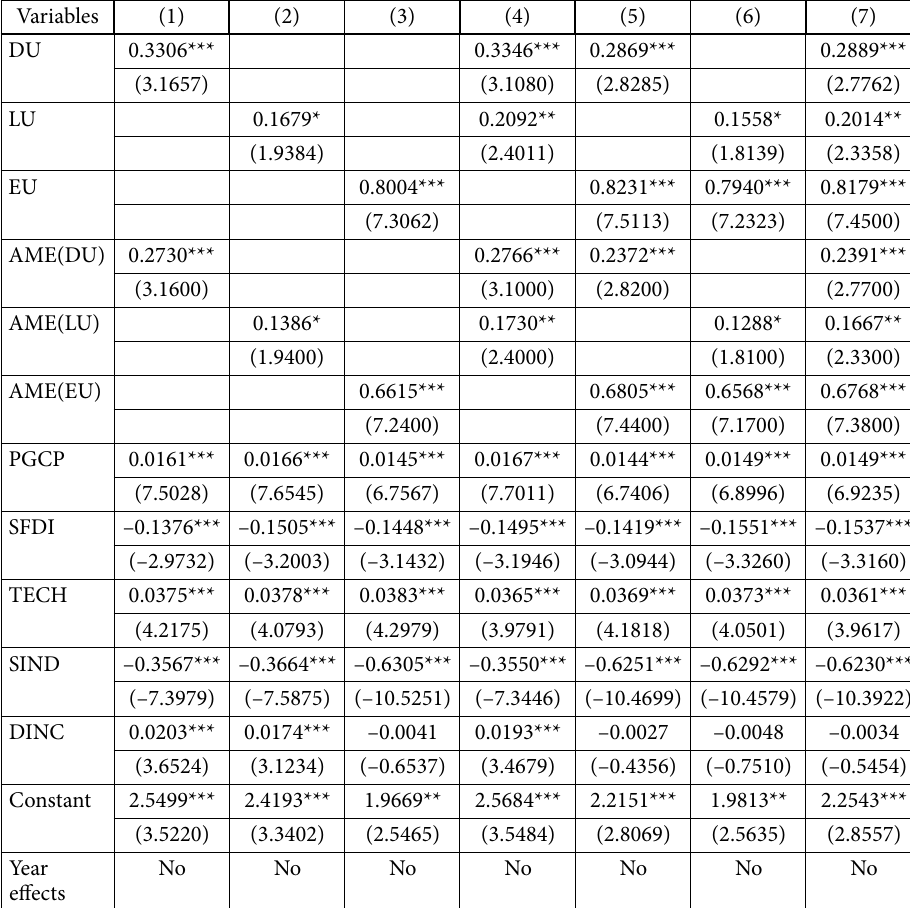
Table 5. Estimation results of Tobit models with correlated random